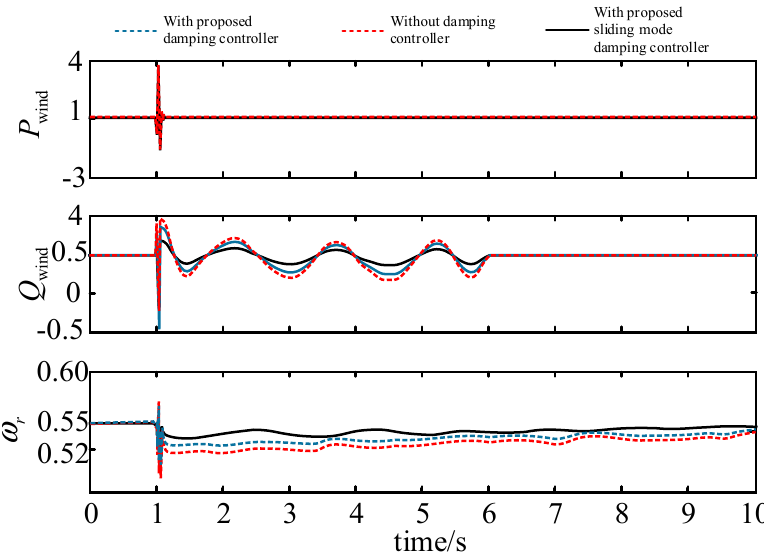
Figure 9. The dynamic reaction of DFIG in case of a malfunction in midpoint.